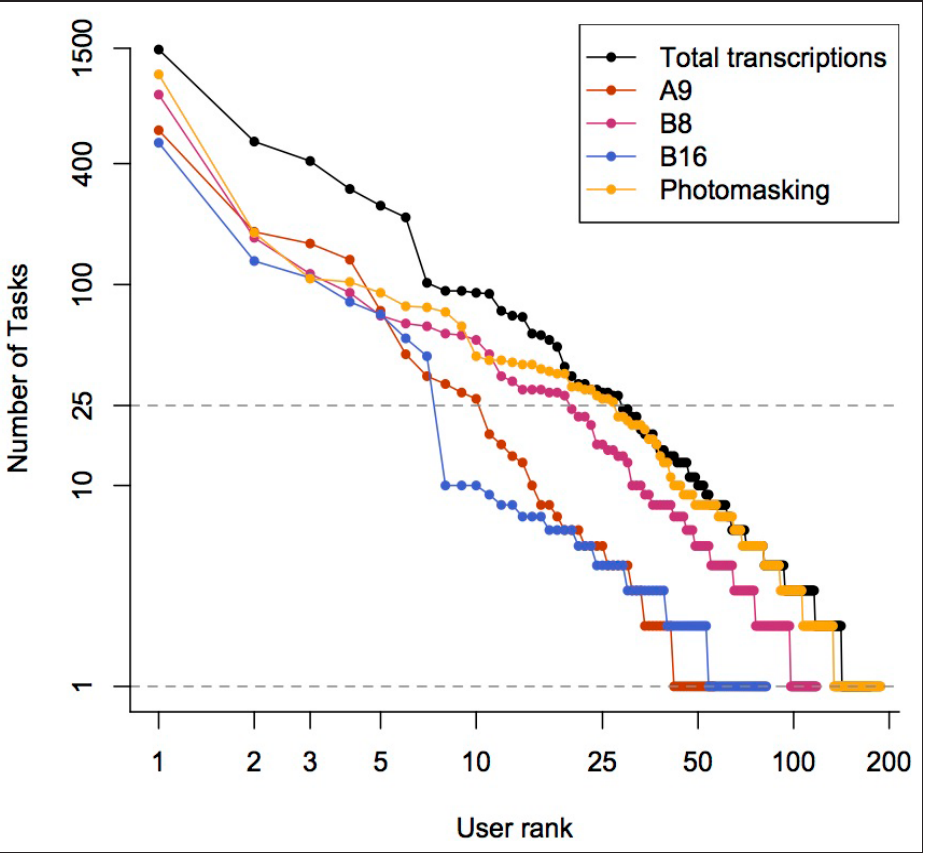
Fig. 6: The distribution of tasks per user across the three transcription applications and one photo-masking application on the MicroPasts site (available at crowdsourced.micropasts.